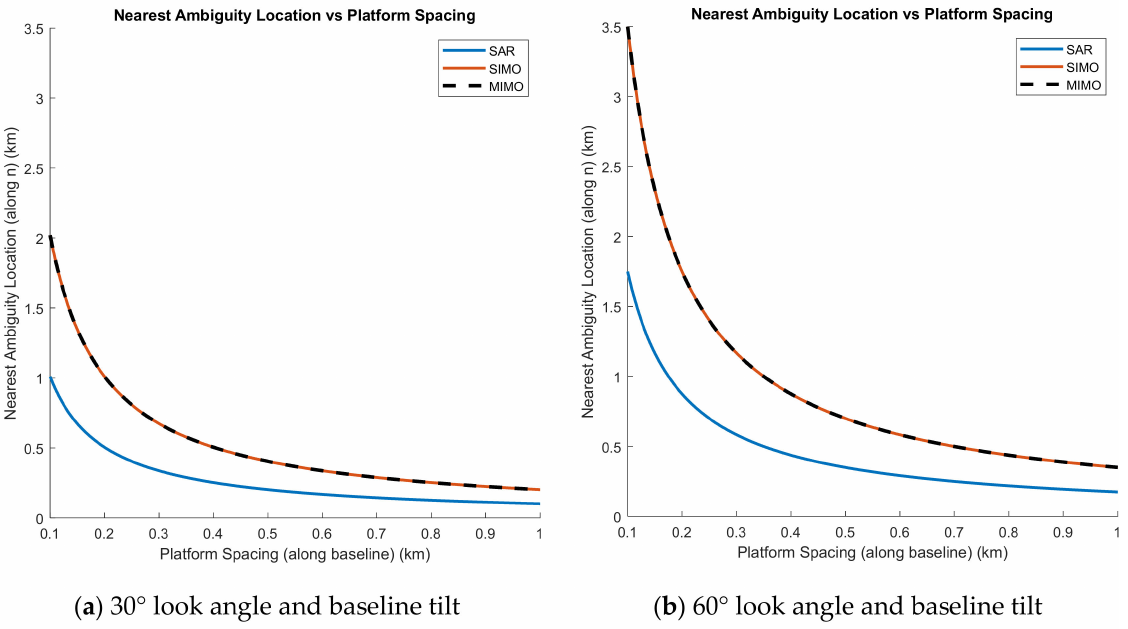
Figure 13. Nearest ambiguity location (along n ) vs. platform spacing (along n ) for two different look angles. As expected, moving the nearest ambiguity further away requires smaller platform spacing. Smallest spacing is required for SAR mode, whereas the SIMO and MIMO modes yield the same spacing requirement. Smaller look angles require smaller spacing to